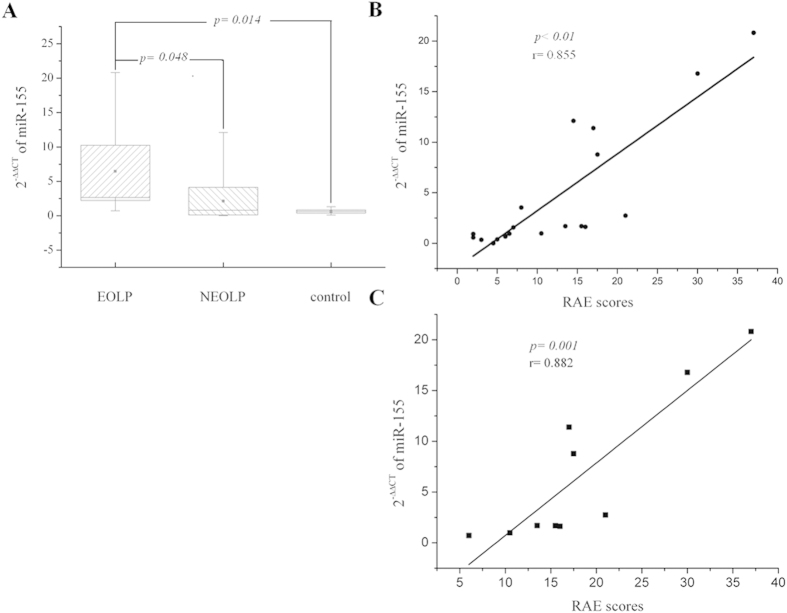
The expression of miR-155 in peripheral blood of OLP.2−ΔΔCT was used to calculate the relative expression of miR-155. The significant differences of miR-155 expression between the groups were tested by Student-Newman-Keuls (SNK) test, and results are represented as box plots. The boxes stretch from the 25th to the 75th percentile; the lines across the boxes indicate the median values; the soft dots in the box indicate the mean values; the lines stretching from the boxes indicate extreme values. Statistical significances are shown in the middle of the lines linking the two compared groups. Pearson’s correlation test was performed, and statistical significance as well as the correlation coefficient is shown. Each dot plot represents a subject, and the correlation is fitted into a straight line.